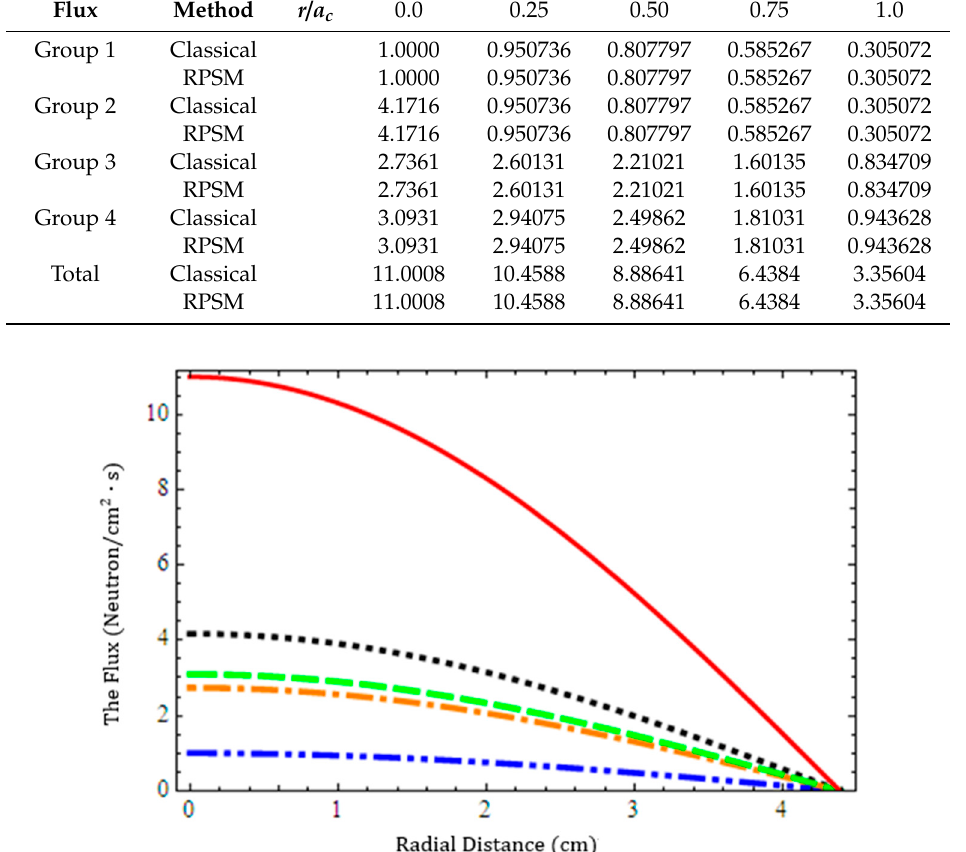
Table 16. The four groups fluxes and total flux in slab reactor geometry.